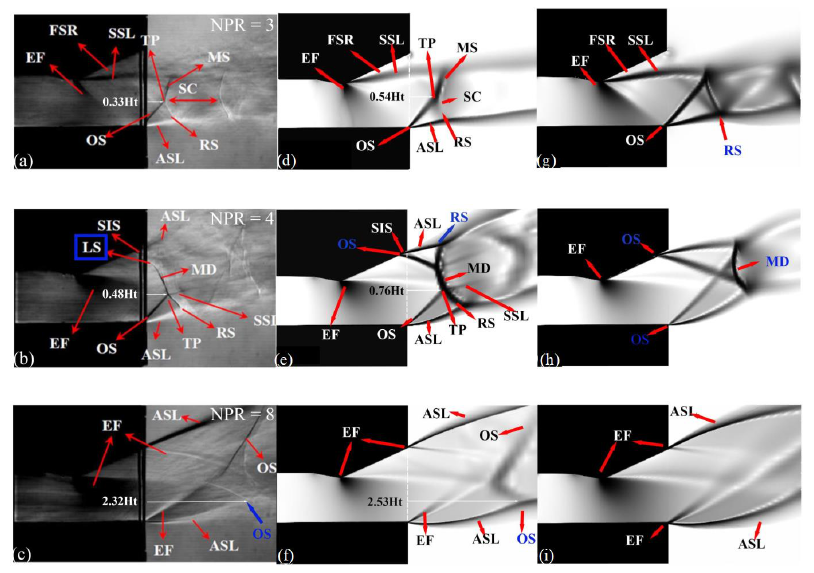
Figure 6. Schlieren and numerical flow visualization images at NPR = 3, 4, and 8. ( a – c ) Experi- mental schlieren measurement; ( d – f ) Three-dimensional numerical Schlieren contours; ( g – i ) Two- dimensional numerical schlieren contours. ASL denotes the atmospheric shear layer, EF denotes the expansion fan, MD denotes the Mach disc, OS denotes the oblique shock, TP denotes the triple point, SSL denotes the separated shear layer, FSR denotes the flow-separated region, CS denotes the curved shock, RS denotes the reflected shock, SIS denotes the shock-induced separation, and LS denotes the lambda shock.